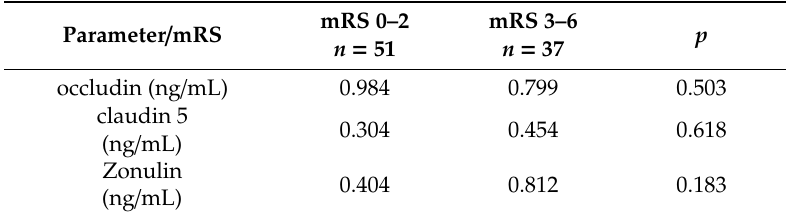
Table 5. The comparison of mean concentrations of occludin, claudin 5, and ZO-1 in subgroups of patients according to mRS (0–2 points vs.